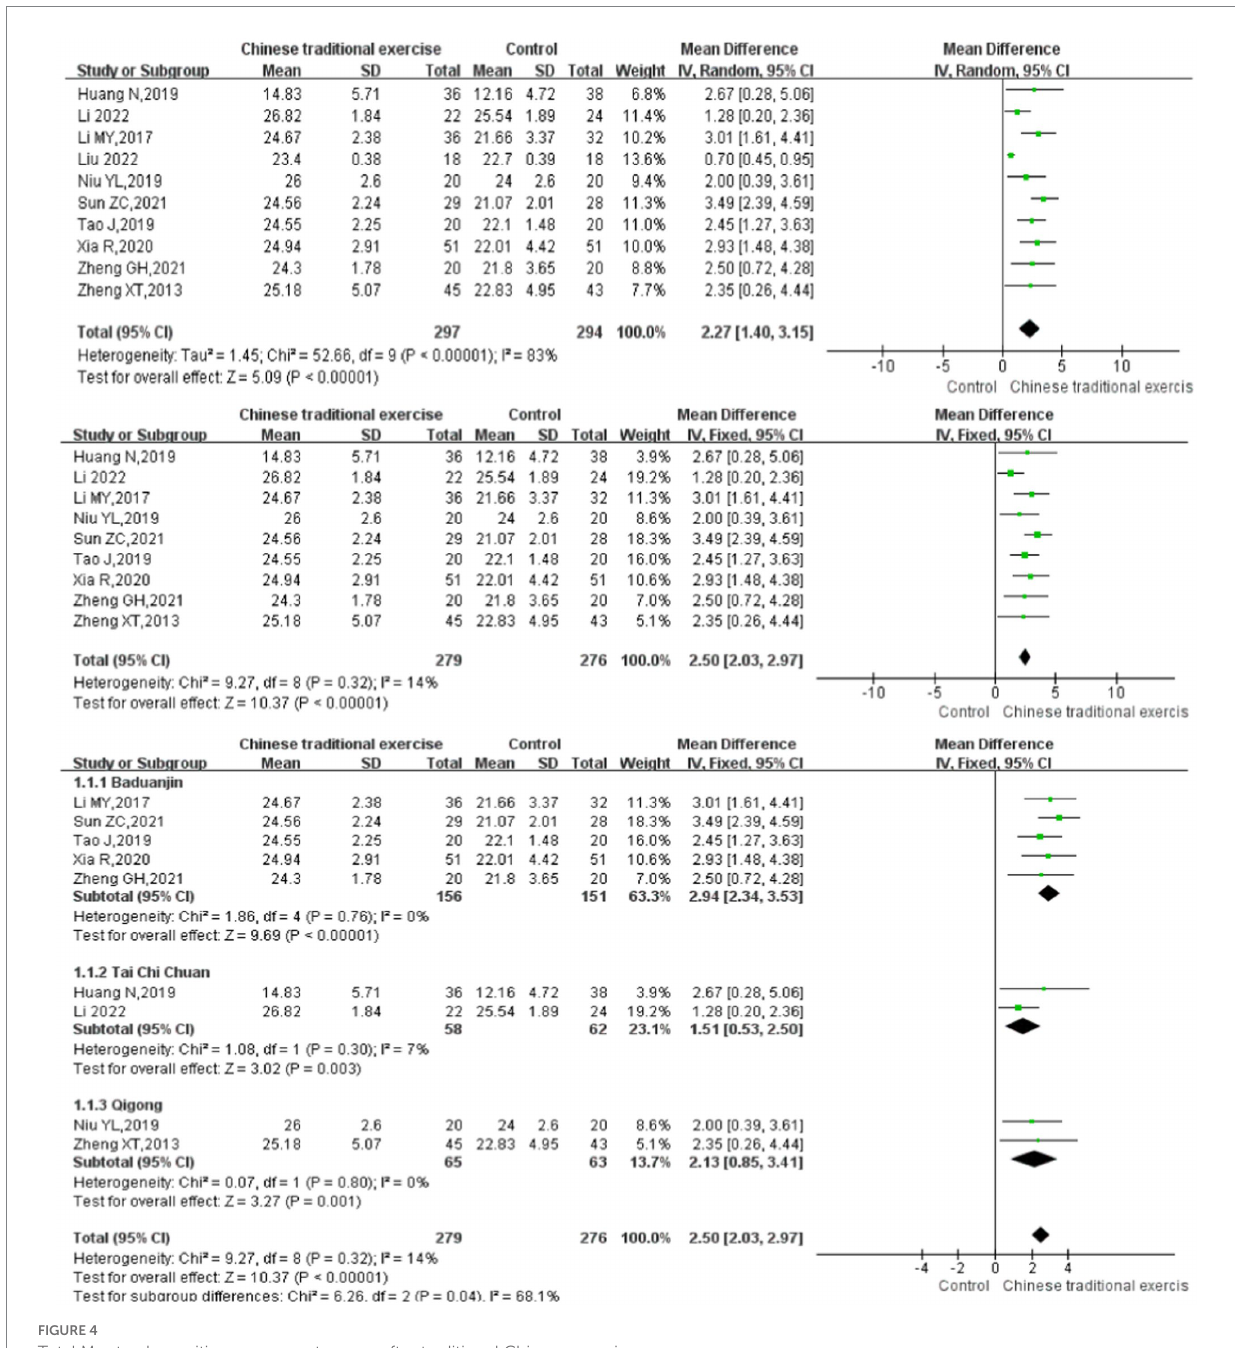
FIGURE 4 Total Montreal cognitive assessment scores after traditional Chinese exercises.